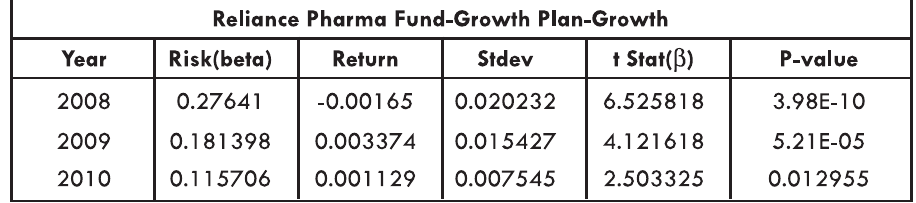
Table 3 : Risk and Returns of Reliance Pharma Fund-Growth Plan-Growth Scheme during the Study Period (2008 to